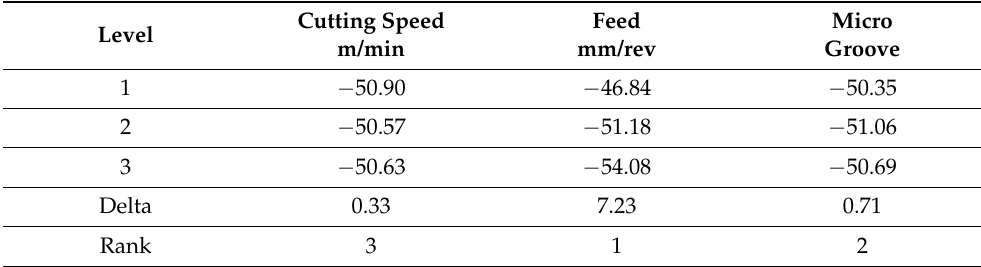
Figure 9. Contour plots for the total power: ( a ) 75 m/min, ( b ) 150 m/min, and ( c ) 225 m/min. Table 8. Total cutting power: Response of signal to noise (SN) ratio.